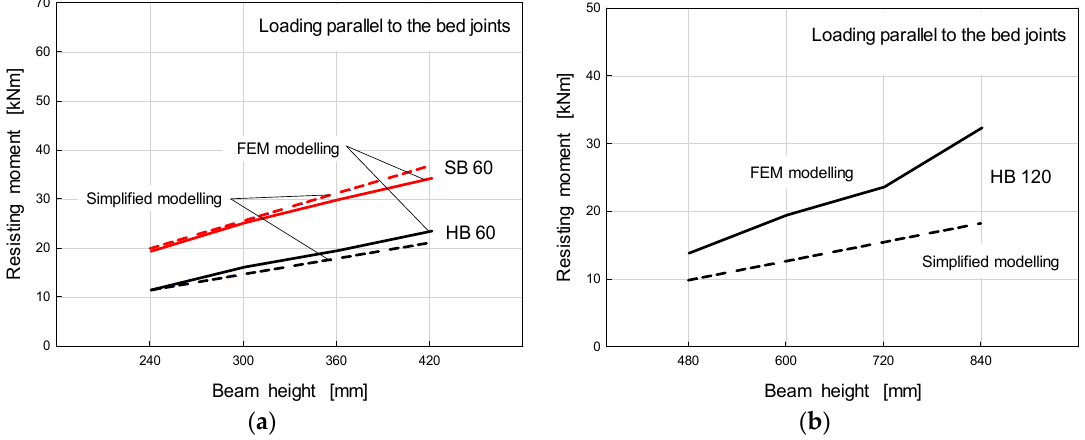
Figure 9. Resisting the bending moments of masonry beams reinforced by flax fibers for loads parallel to the bed joints: ( a ) solid and hollow bricks 60 mm thick; ( b ) hollow bricks 120 mm thick .